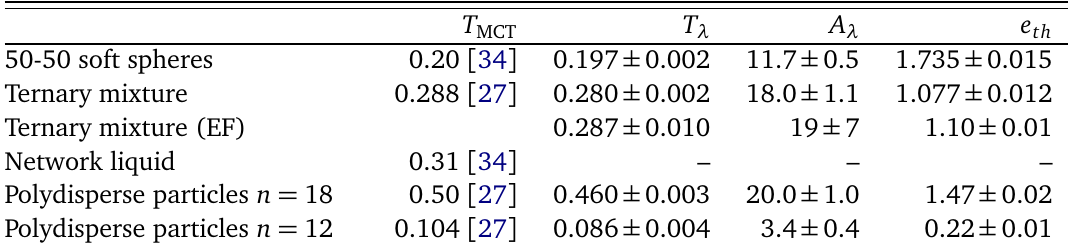
, localization transition temperatures T λ , MCT for all the studied models. Note that th